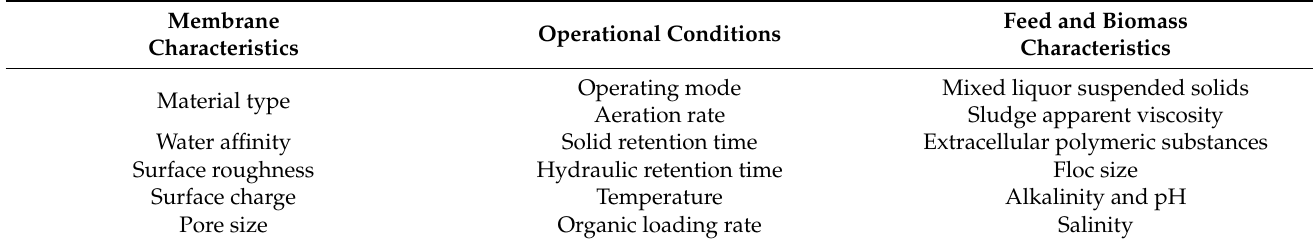
Table 1. The factors affecting membrane fouling in